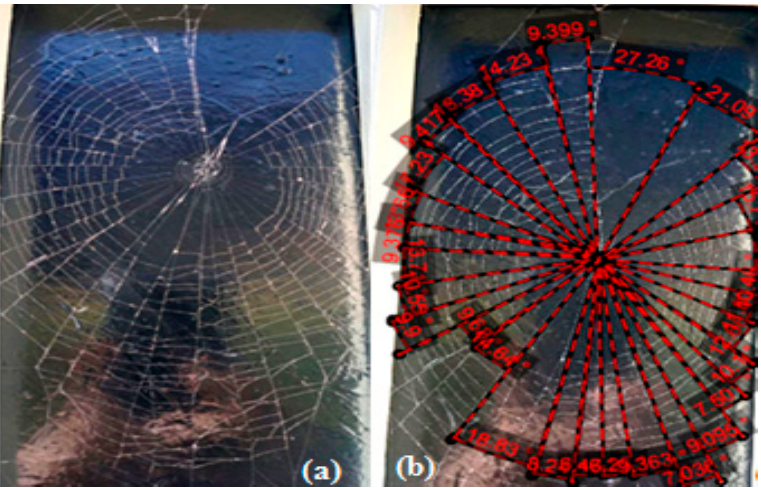
Figure 5. ( a ) Unmeasured image ( b ) measured image of SP4.